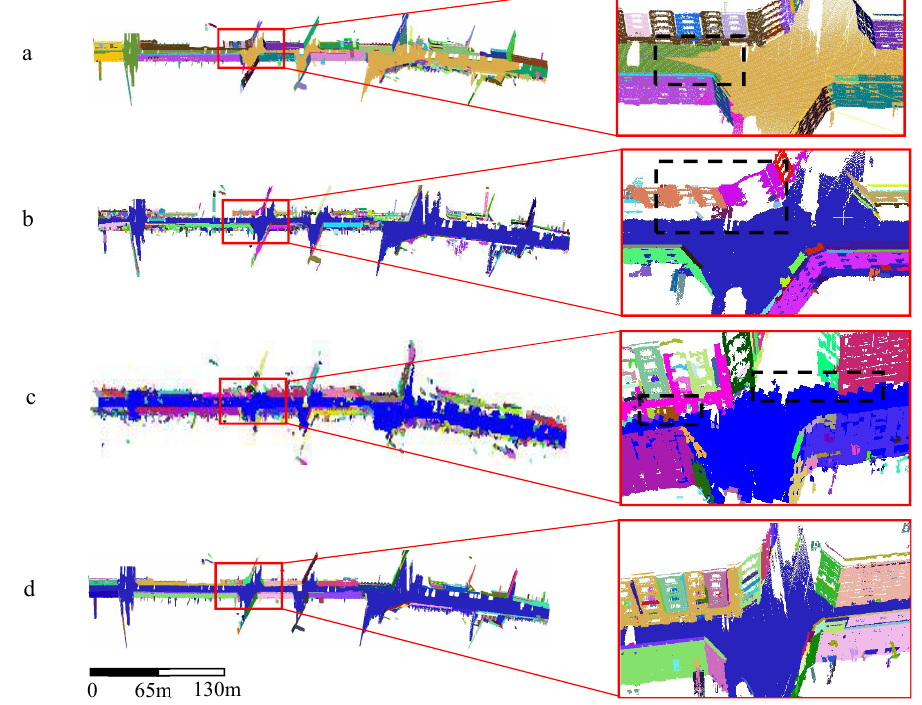
Figure 13. Segmentation results of mobile laser scanner data. ( a ) Segmentation results of ER algorithm, ( b ) segmentation results of SCRG algorithm, ( c ) segmentation results of VGS, and ( d ) segmentation results of the EVBS. Table 3. Plane segmentation results using mobile laser scanner data.